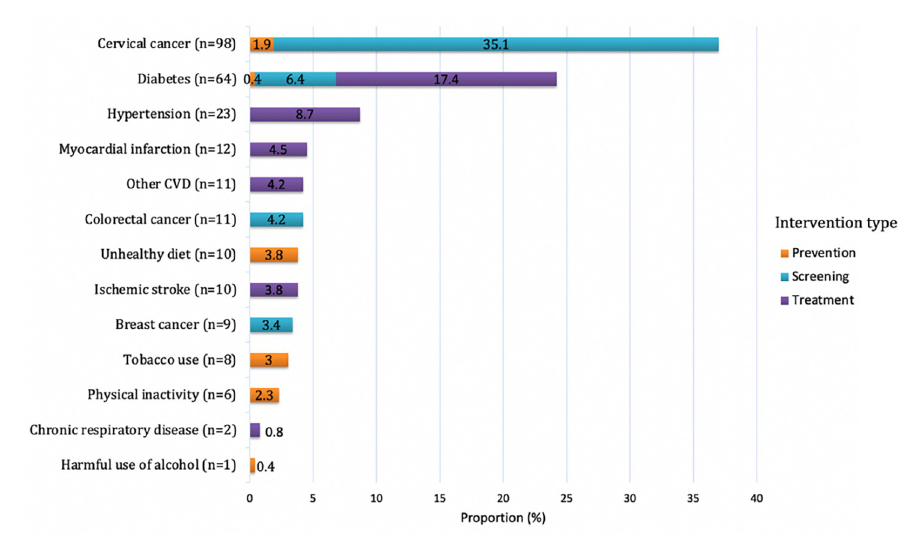
Fig 2. Distribution of priority NCD prevention and control interventions by type of NCD and their risk factors ( N = 265). https://doi.org/10.1371/journal.pmed.1004055.g002 0.5% of deaths globally, with similar figures for LMICs (https://vizhub.healthdata.org/gbd- compare/). Diabetes was the focus of nearly one-quarter of the research with hypertension the topic of another 9% (Fig 2). Each of the other recommended interventions represented 5% or